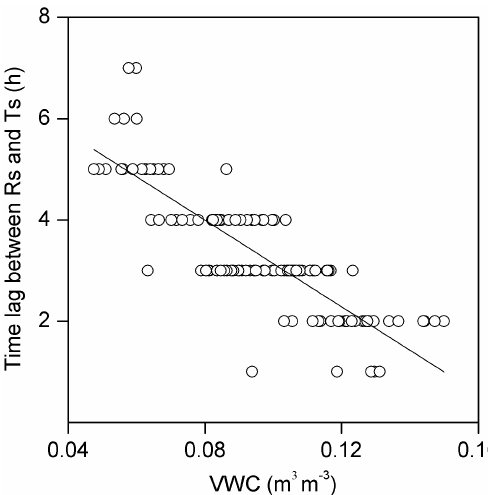
Fig. 4. Mean monthly diel cycles of soil respiration (Rs) and soil temperature (Ts) from Fig. 1, but replotted in relation to each other. The solid line is fitted by the Q 10